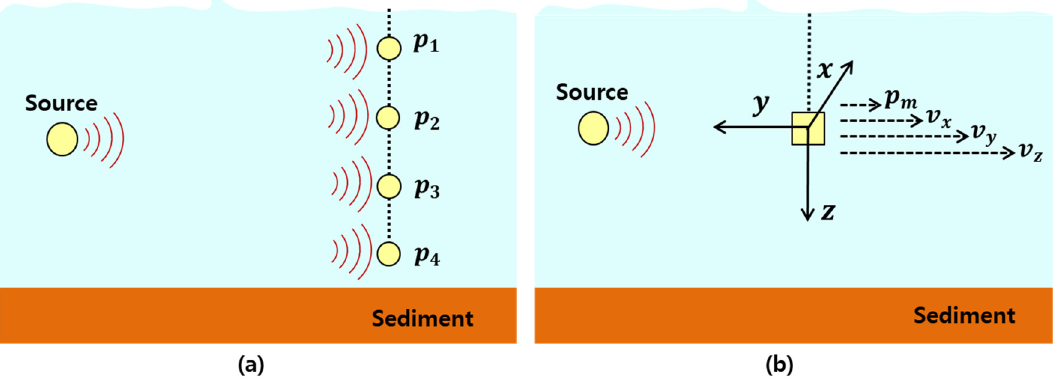
Figure 1. Communication system layouts. ( a ) Vertical-pressure sensor array, ( b ) single-vector sensor.